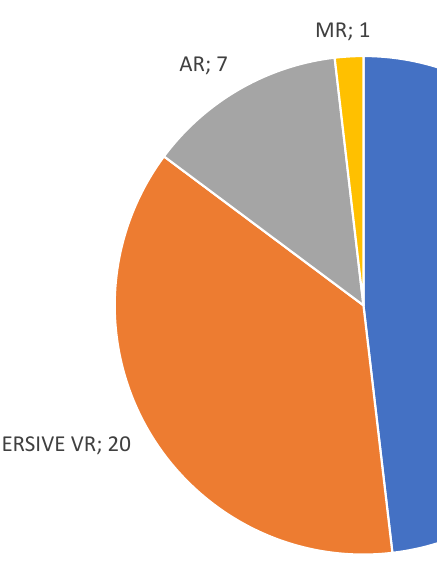
Figure 8. Number of times that immersive VR, non-immersive VR, AR, and MR technologies were used in the 41 works analyzed.